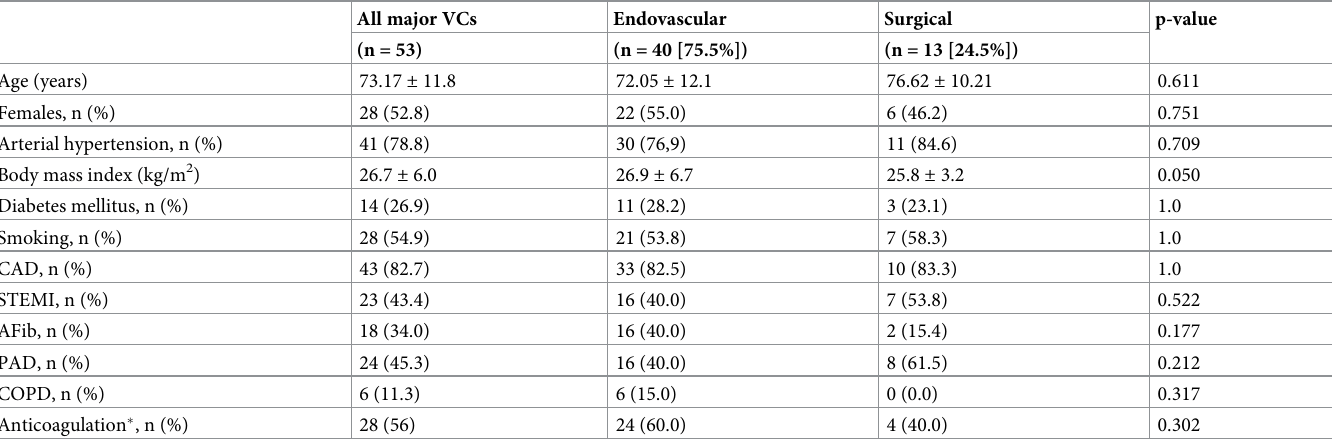
Table 1. Baseline characteristics for all patients with major vascular